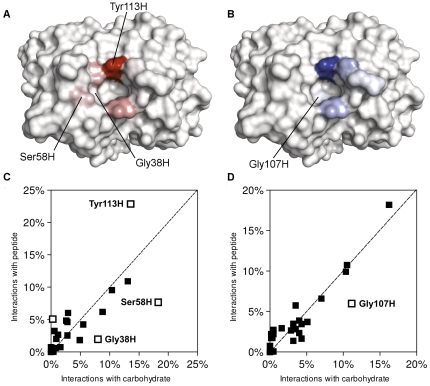
Peptide mimicry of GD3 binding to R24.A. Hydrogen bonding site map describing peptide (RHAYRSMAEWGFLYS) recognition by R24. B. van der Waals interaction site map describing peptide recognition by R24. Site maps generated and rendered using PyMOL [64]. C. Comparison of hydrogen bonding site maps describing GD3 and peptide recognition. D. Comparison of van der Waals site maps describing GD3 and peptide recognition. In Figures 6C and 6D, open points indicate residues which deviate significantly from the line representing equivalence of carbohydrate and peptide interactions (i.e., |d|>3.00). The open point not labeled on Figure 6C corresponds with Tyr114H.